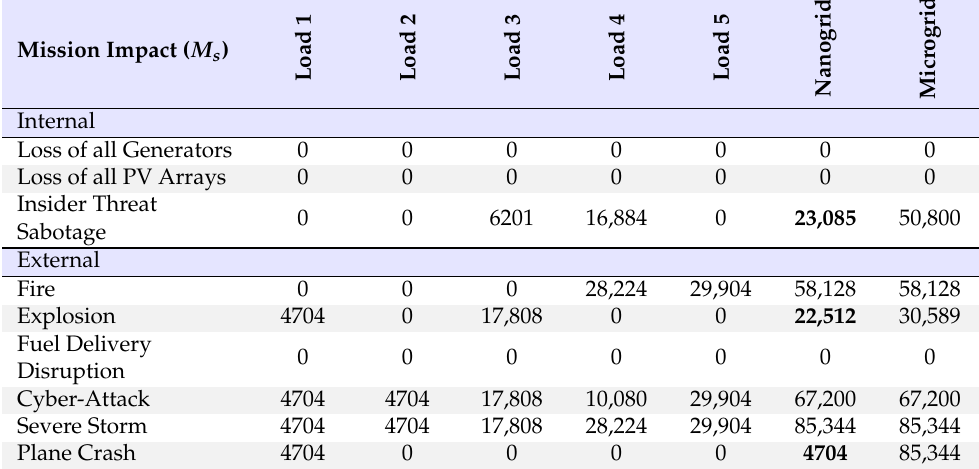
Table 8. Mission Impact Simulation Results. The Mission Impact ( M s ) values for the nanogrid and microgrid architectures are shown for each threat. The bold values indicate the lower mission impact (less impactful, better) outcome. In all cases, the nanogrid either performs the same or better than the microgrid architecture.